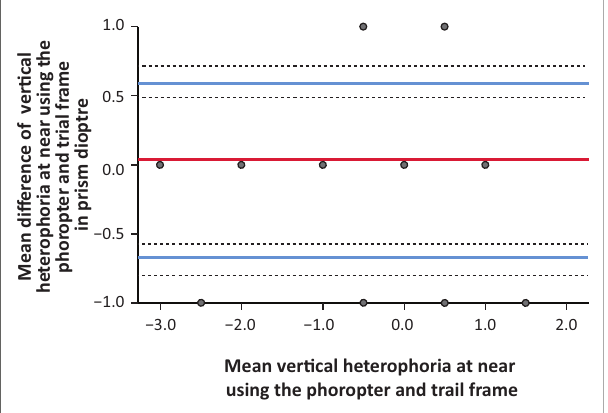
The 95 % limits of agreement are shown with solid blue lines. Units are in prism dioptres. FIGURE 10: Bland-Altman graph showing the mean difference (red line) between the vertical heterophoria measured at near vision using the phoropter and trial frame. TABLE 5: Intraclass correlation of heterophoria measurements using the phoropter and trial frame.